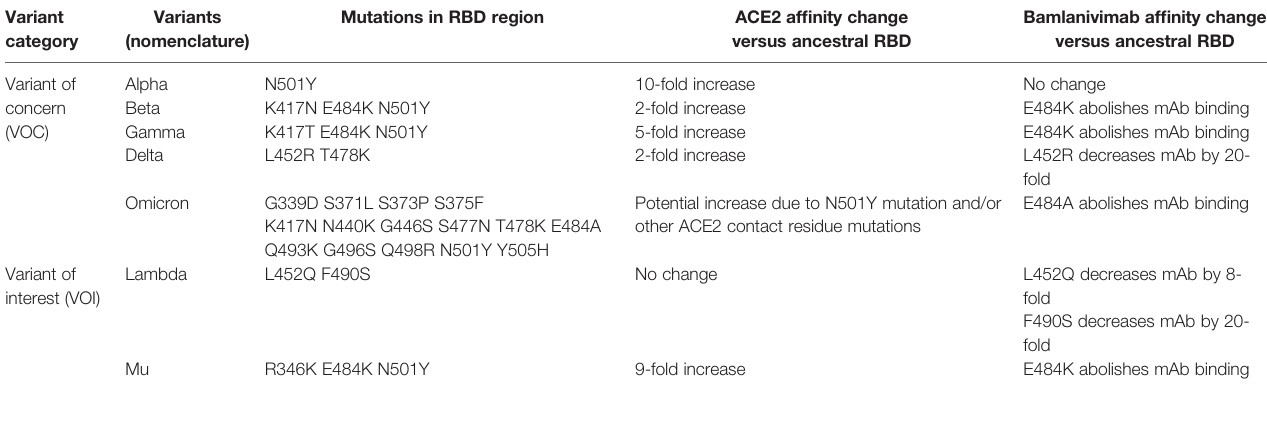
TABLE 1 | SARS-CoV-2 VOC and VOI RBD mutations on ACE2 or bamlanivimab af fi